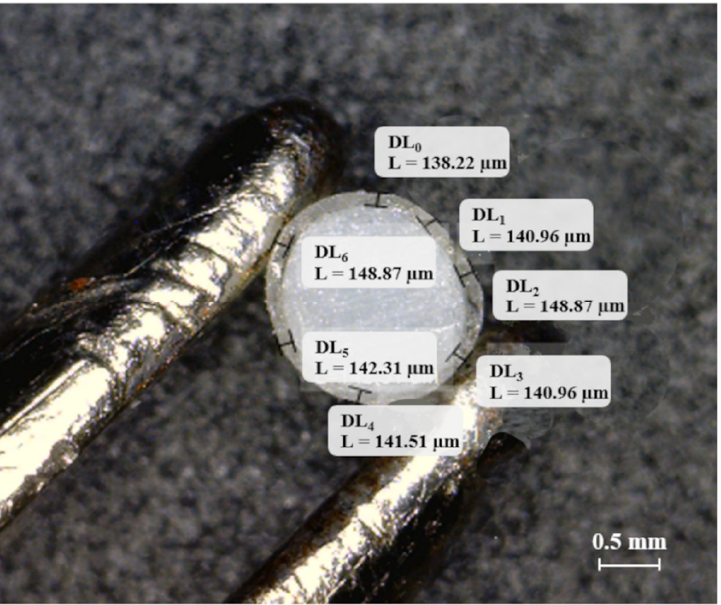
Figure 1. Digital photograph of the cross-section of an extruded rod coated for 16 min with the Eudragit ® NE aqueous suspension with thickness measurements taken in 7 different positions (DL 0 –DL 6 ).